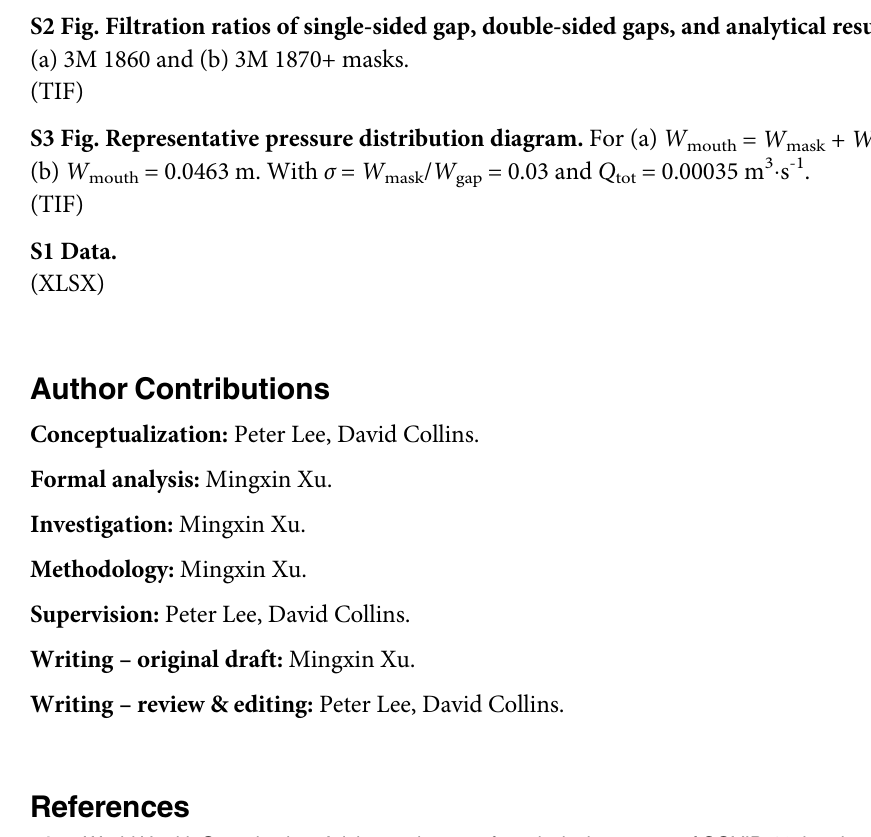
= W + W and mouth mask gap / W = 0.03 and Q = 0.00035 m 3 � s -1 . mask gap tot